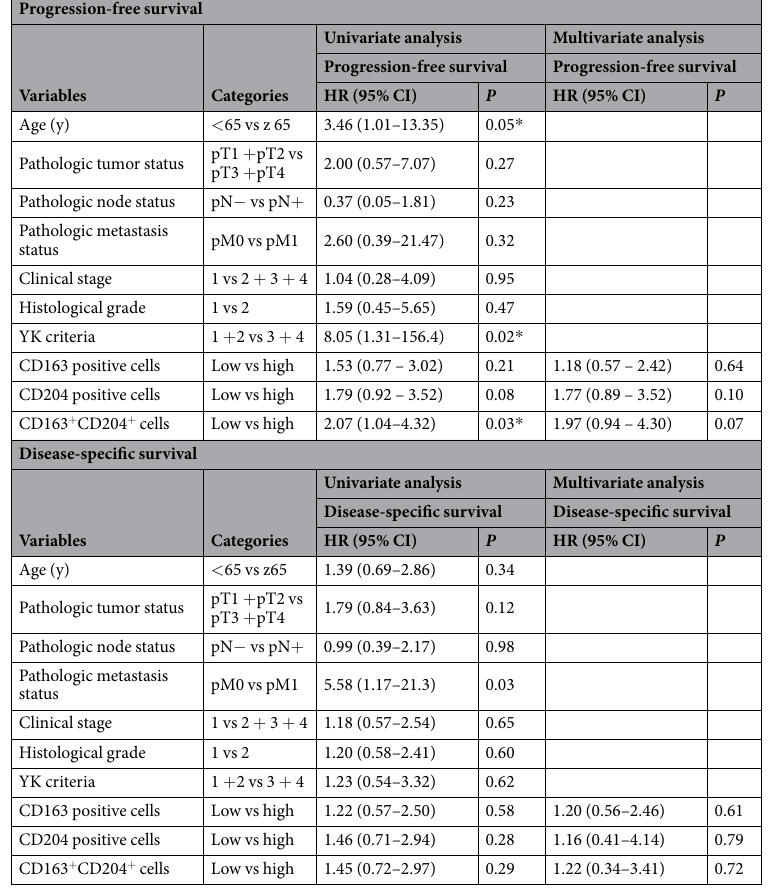
Table 2. Univariate and multivariate analysis of progression-free survival and disease-specific survival in advanced stage. HR, hazard ratio; CI, confidence interval, *